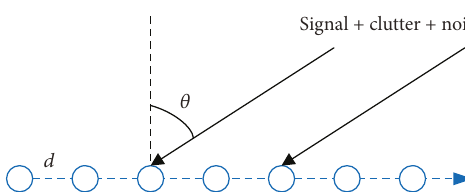
Figure 9: Framework of the IMLC.